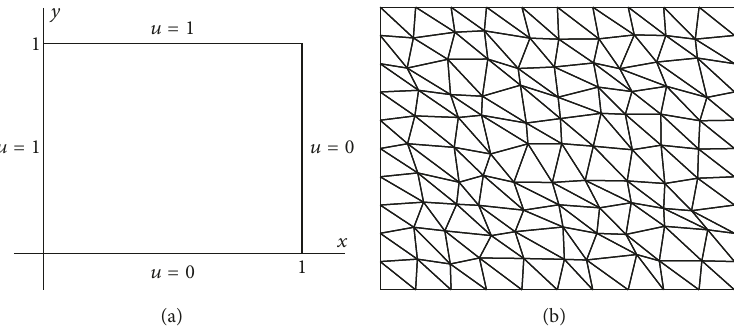
Figure 14: (a) Configuration of Experiment 2. (b) Triangular elements used in discretization of the problem